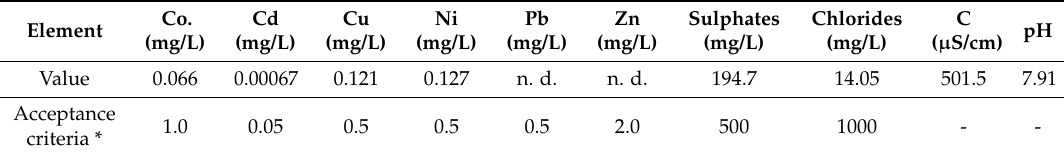
Table 5. Leachate concentration from recycled concrete